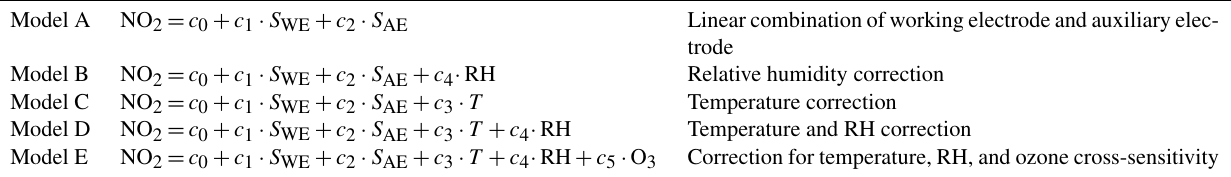
Table 2. Regression models for NO 2 . Model A